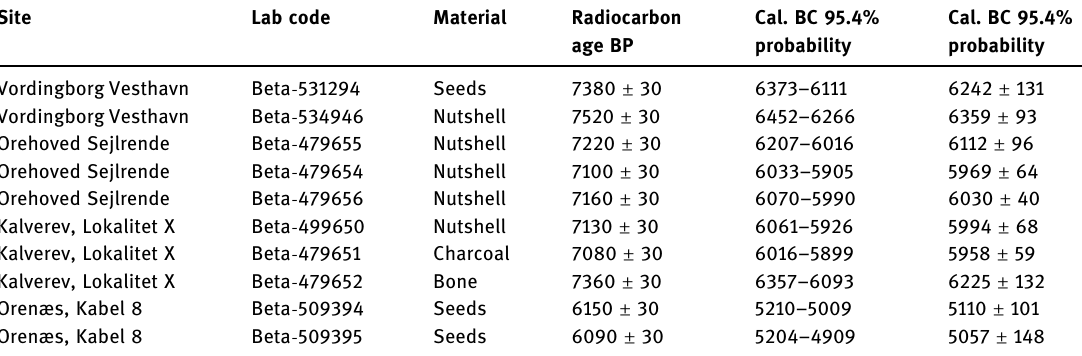
Table 1: Radiocarbon dates from the sites. Dates have been calibrated using the InterCal13 curve in BetaCal 3.21